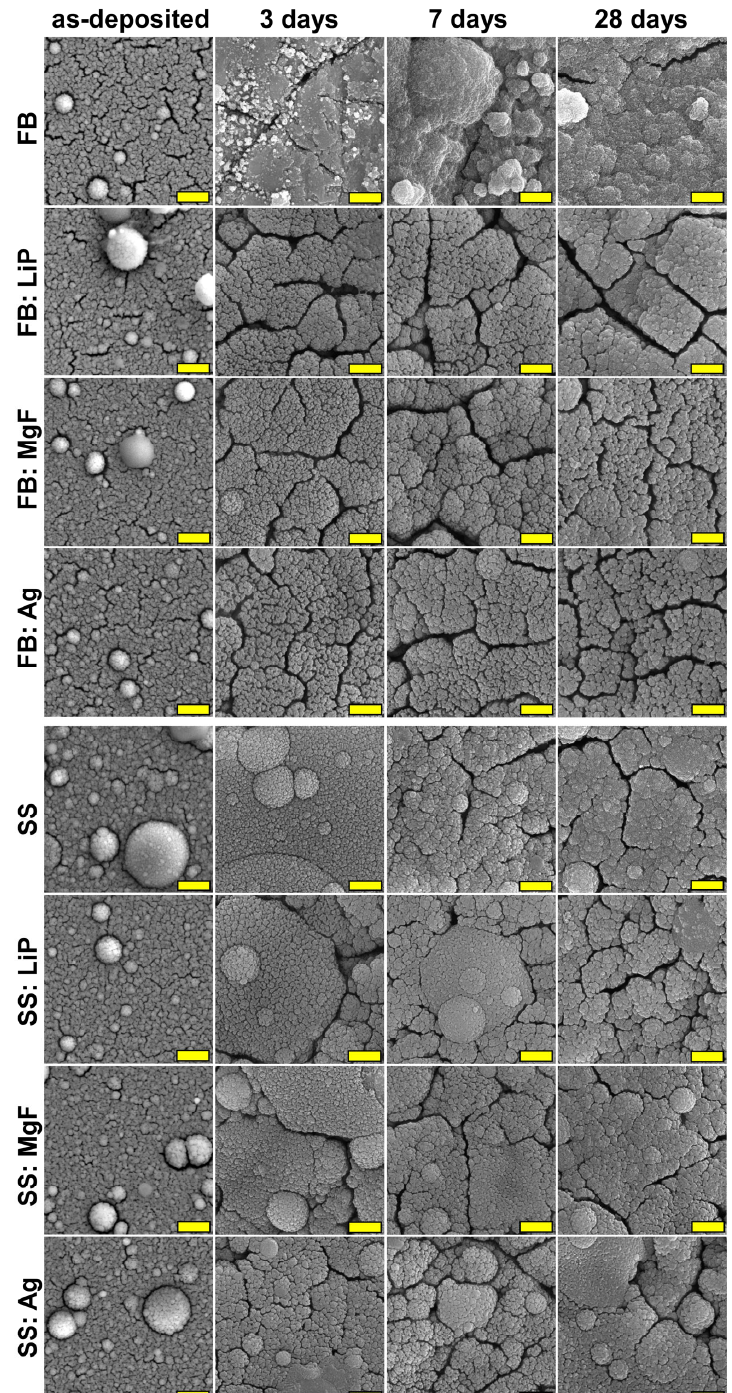
Figure 8. SEM images of the surface of the simple and doped FB- and SS-based thin films before and after testing in the complete DMEM-FBS solution for different time intervals (3, 7, and 28 days). Magni fi cation bar: 500 nm.